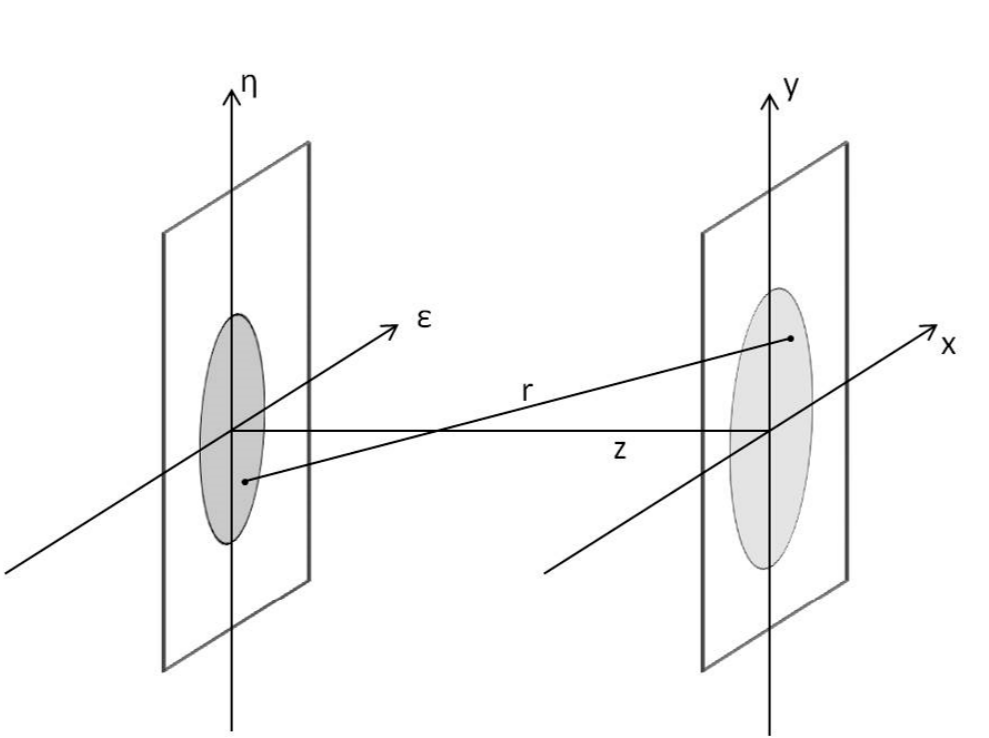
Figure 1. Schematic representation of the coordinates system: the wave field is defined in the ( ε , η ) plane and propagated until the second plane ( x , y ). The propagation direction z is orthogonal to both